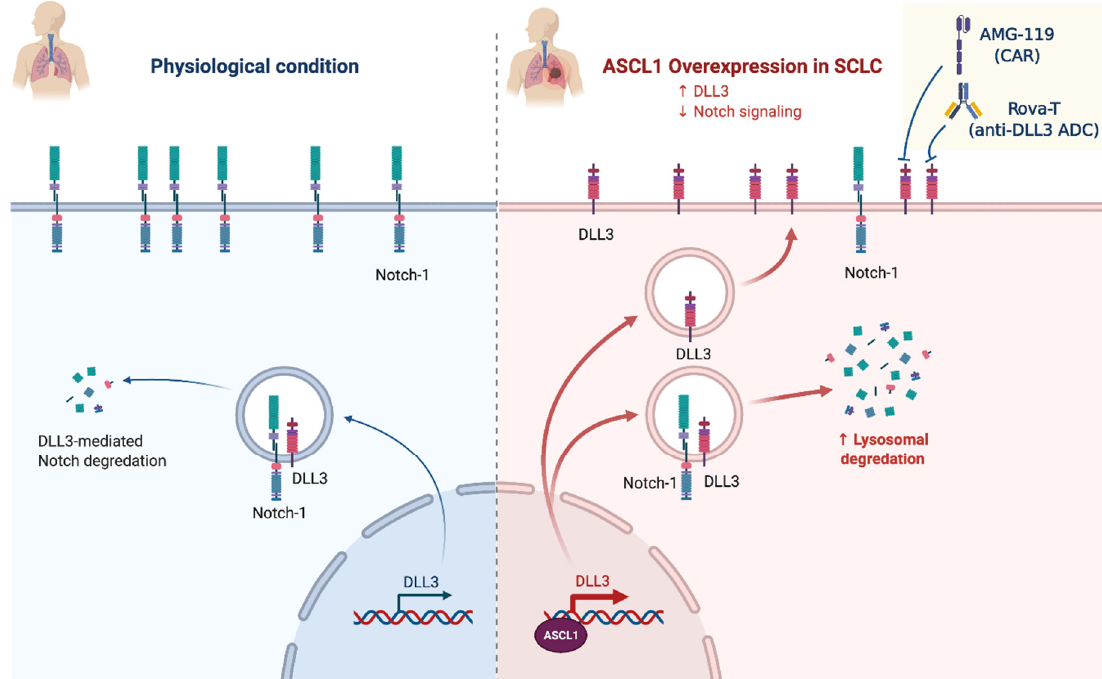
Figure 2. ASCL1 overexpression in SCLC and exploitation of DLL3 as therapeutic target (created with BioRender.com, accessed on 24 February 2021).